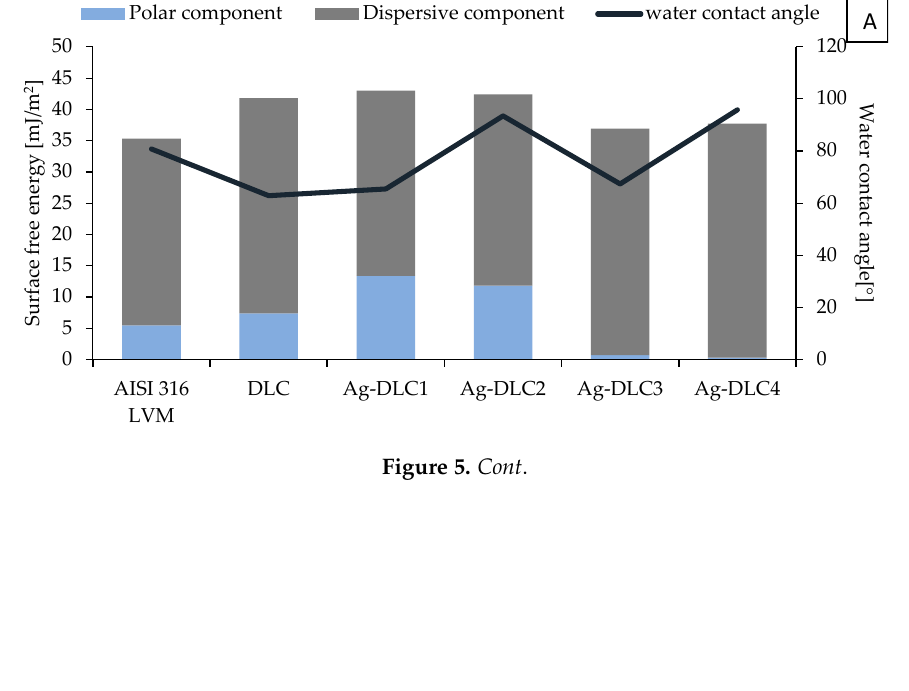
Figure 4. Curve fitting of Cu 2p 3/2 XPS spectra—example for Cu-DLC1 coating deposited on AISI 316LVM ( left ). The Cu 2p 3/2 peak and the satellite peak for Cu-DLC4 coating deposited on Ti6Al7Nb alloy ( right ). Both total SFE (polar and dispersive components) and values of contact angle for water are presented in Figures 5 and 6. The hydrophobicity of the coatings increased with the addition of elements of admixture. SFE of Ag-DLC coatings was at a similar level, ranging from 35 to 42 to mJ/m 2 . For silver content of about 7 at.% and higher, the depletion of polar component to the level of 1 mJ/m 2 was observed.